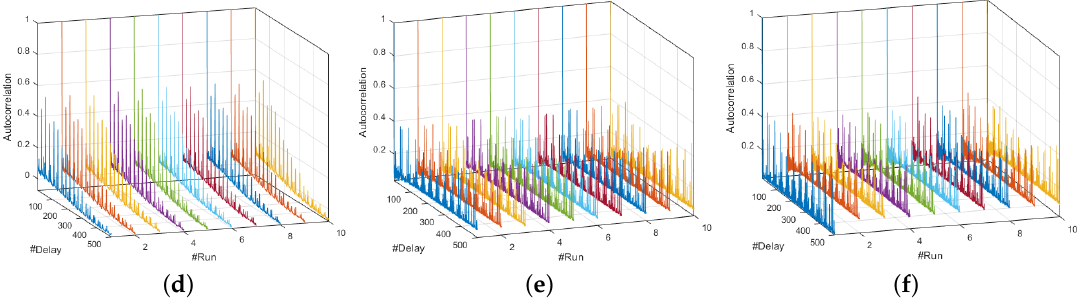
Figure 14. Representative SAFs for the ZigBee network. From left to right: 9600, 19,200, and 57,600 bauds. ( a – c ) Realizations 5, 1, and 8; and ( d – f ) M-modes of Sensor Node 1 at each speed.